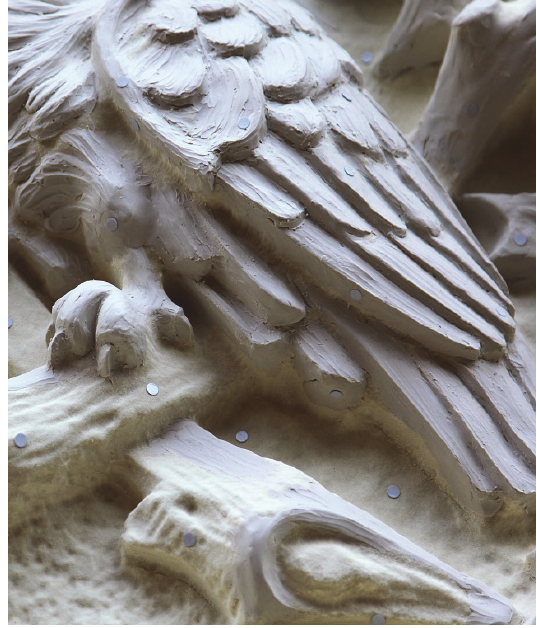
Figure 6. Detail of CNC-milled polyurethane foam maquette of relief sculpture with modelling clay